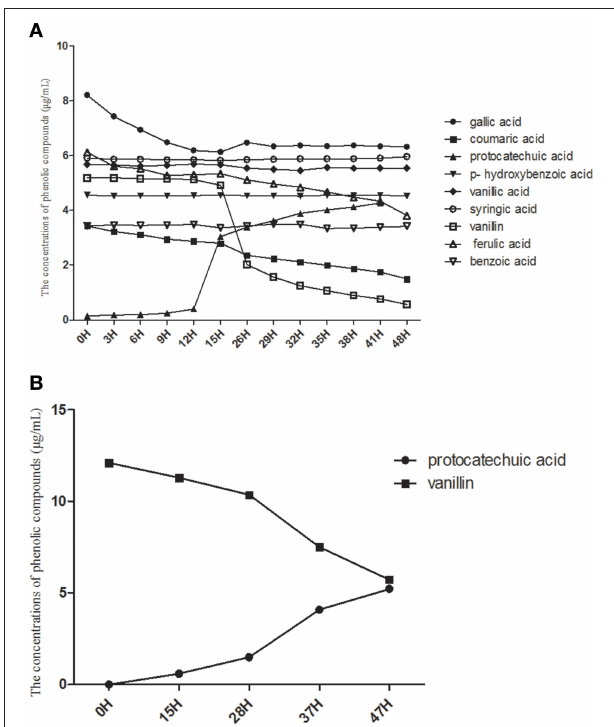
FIGURE 8 | The consumption of phenolic compounds (A) and single vanillin (B) by Kosakonia W.